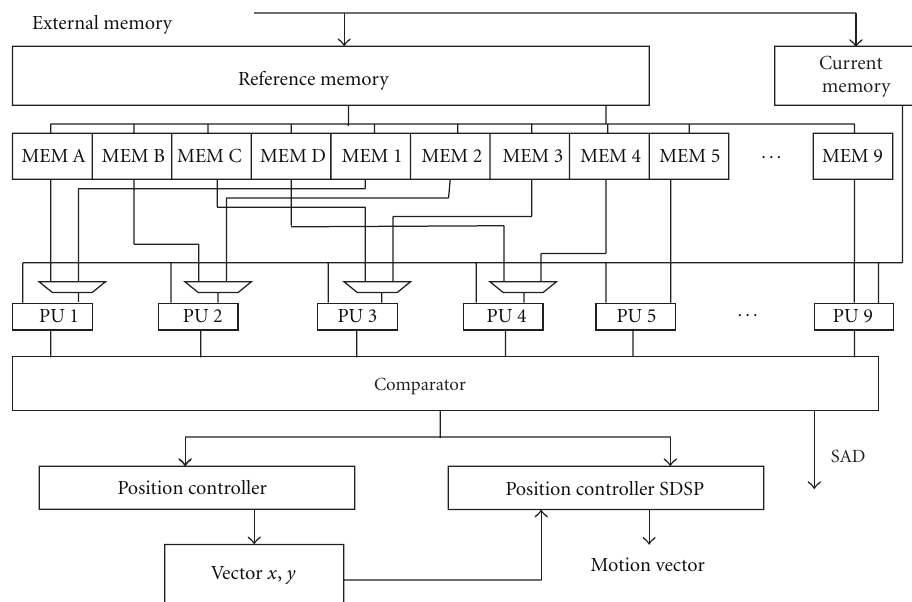
Figure 8: Block diagram of the DS core